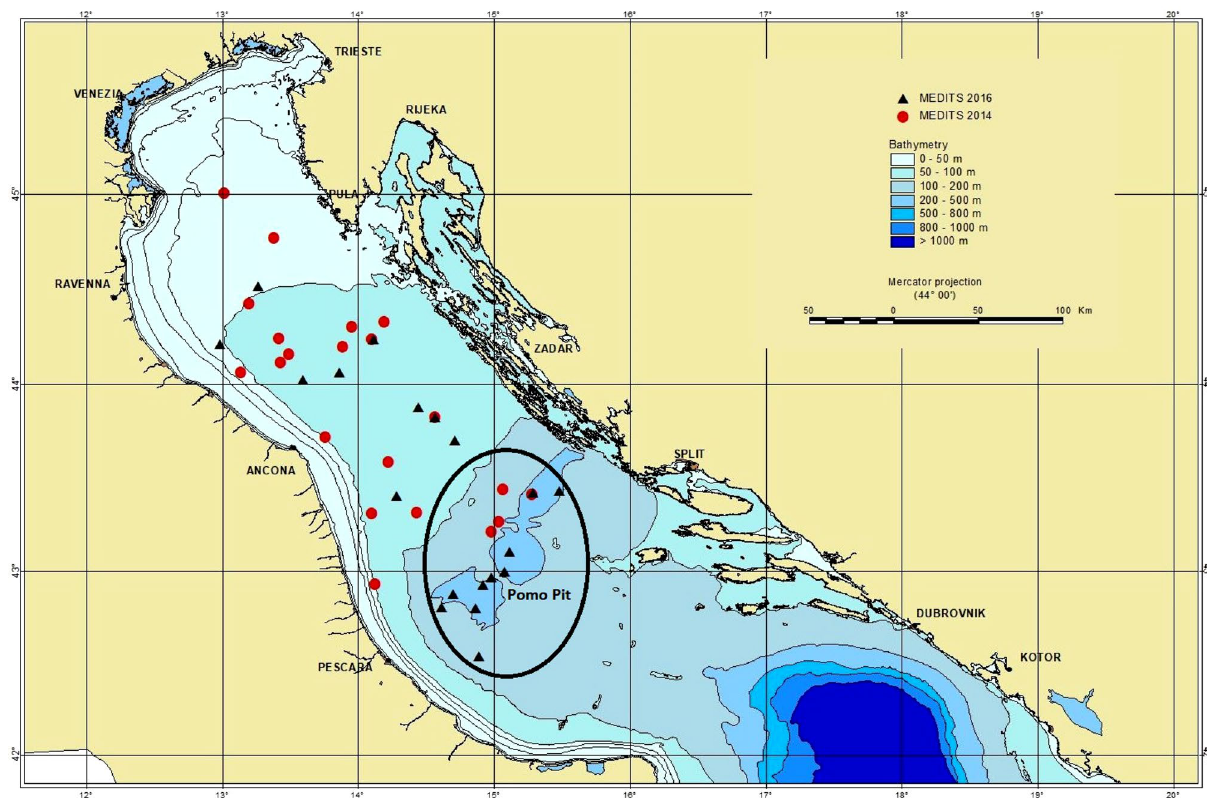
Figure 1. Map of the sampling hauls in the NC Adriatic Sea: triangles depict samples collected in 2016, circles samples collected in 2014. Further details can be found in Supplementary Material Table S1. This map was created using ArcViewGIS version 3.2a (https:// geonet. esri. com/ thread/ 36365). The Adriatic cartography used is freely available at http:// www. faoad riamed. org/ html/ adr_ inf_ centre. html# inter-size class dissimilarity computed within each habitat (within and outside the Pomo Pit) were P: 0.677 and S: 0.45, while the corresponding mean within-size class values were P: 0.53 and S: 0.73 (Supplementary Table S3). The Principal Coordinate Analysis (PCoA) plot (Fig. 3), based on the Bray–Curtis dissimilarities computed on Hellinger transformed occurrence data, showed a significant clustering among the size classes (permutest P -value = 0.004). An important dietary differentiation of the size class TL 150–199 was apparent, resulting sig- nificantly differentiated from most of the other samples collected in the Pomo Pit and from all the size classes collected outside the Pomo Pit (revealed by the significant comparisons P -value ranging between 0.001 and 0.009, Supplementary Table S4). A certain level of dietary partitioning was detected for the largest size class from the Pomo Pit (TL ≥ 300 P), which gave 1%- and 5%-significant pairwise comparisons with most of the other size classes. Interestingly the PCoA plot clearly separated the two small-sized classes within the Pomo Pit from the large-sized classes that clustered together on the top of the plot (pink, red and black squares, Fig. 3). On the contrary, all the samples collected outside the Pomo Pit, at shallower depth, clustered together showing a slight differentiation among size classes (light-blue and grey dots, Fig. 3). This result suggested the presence of a rela- tionship between the pattern of differentiation among the size classes and depth also supported by the ANOSIM analysis (r 2 = 0.27, P -value < < 0.01) and the permutational PERMANOVA analysis (r 2 = 0.33, P -value < < 0.01) showing that the tested grouping accounted for about a 30% of the variance present in the data. The PERMANOVA analysis also identified the habitat as a factor significantly driving feeding behaviour (r 2 = 0.11, P -value < < 0.01) and when considering the interaction between size classes and habitat (r 2 = 0.33, P -value < < 0.01). Moreover, the vector computed by using depth as environmental variable ( envfit analysis) showed a significant P -value ( P -value = 0.001) and a r 2 = 0.47 (Fig. 3). The bipartite network depicting diet composition (Supplementary Fig. S2, on the top) showed a higher complexity of prey-predator relationships among the M . merluccius samples collected at shallower depth. In the samples collected within the Pomo Pit the number of links per size class was 1.25 whereas in the samples col- lected at shallower depth the number of links per size class was 1.78 Moreover, the weighted connectance was 0.16 in the deep samples and 0.25 in the shallow samples suggesting the presence of a constraint in the diet for M. merluccius individuals sampled inside the Pomo Pit and of a narrower spectrum of preys in this deep area. The weighted NODF value was lower in the Pomo Pit sample (17) than in the shallower sample (31) revealing that some size classes are characterized by a higher degree of niche overlap outside the Pomo Pit confirming previous results 35 . Distribution density of prey among the M. merluccius size classes was displayed by using a heat map of the network (Supplementary Fig. S2) which gave a simple visualisation of the species detected. The heat map